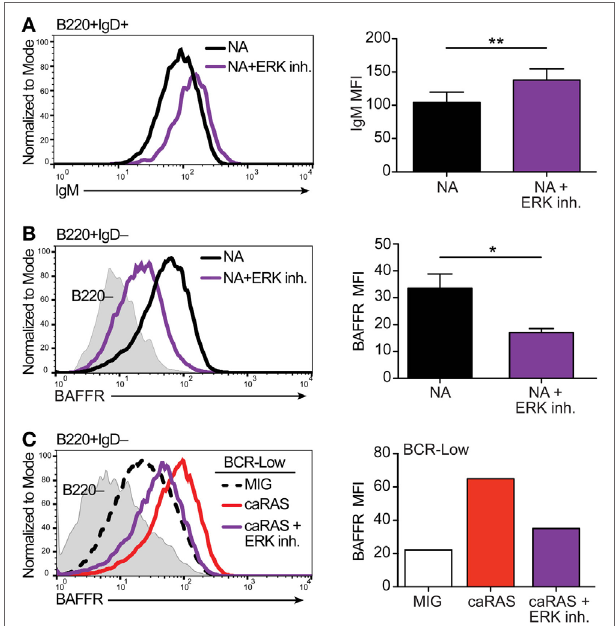
FigUre 1 | Extracellular signal-regulated kinase (ERK) contributes to establishing appropriate expression of the BCR and BAFFR on immature B cells. (a) Representative histograms and quantification of IgM levels on nonautoreactive (NA) (3-83Igi,H-2 d ) bone marrow cells that were cultured in IL-7 for 4 days and then incubated with either BAFF + DMSO (black) or BAFF + 30 µM ERK1/2 inhibitor (FR180204, purple) for 3 days. Shown are B220 + IgD + transitional B cells. N = 4 total, from four independent experiments. (B) Representative histograms and quantification of BAFFR levels on NA bone marrow cells that were cultured in IL-7 for 4 days along with either DMSO (black) or 30 µM ERK1/2 inhibitor (purple). Shown are B220 + IgD – immature B cells. N = 3 total, from three